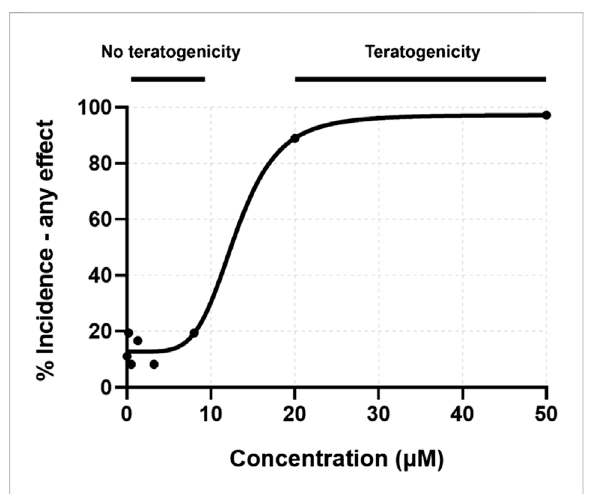
FIGURE 2 Concentration-response curve for percent incidence of any teratogenic effect observed at 24 or 120 hpf. Exposure concentrations for toxicity screening were matched to those for transcriptomic